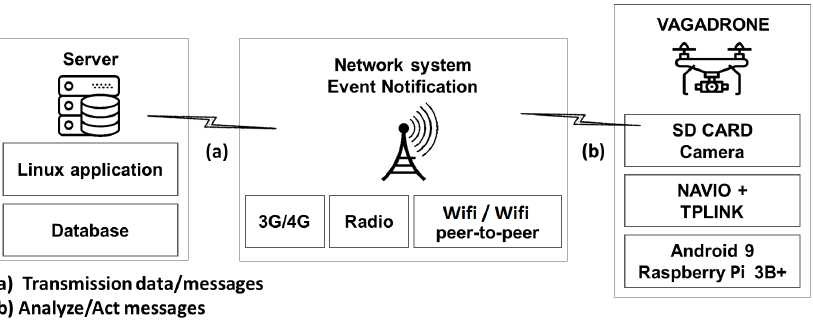
Figure 1. Global architecture of the proposed